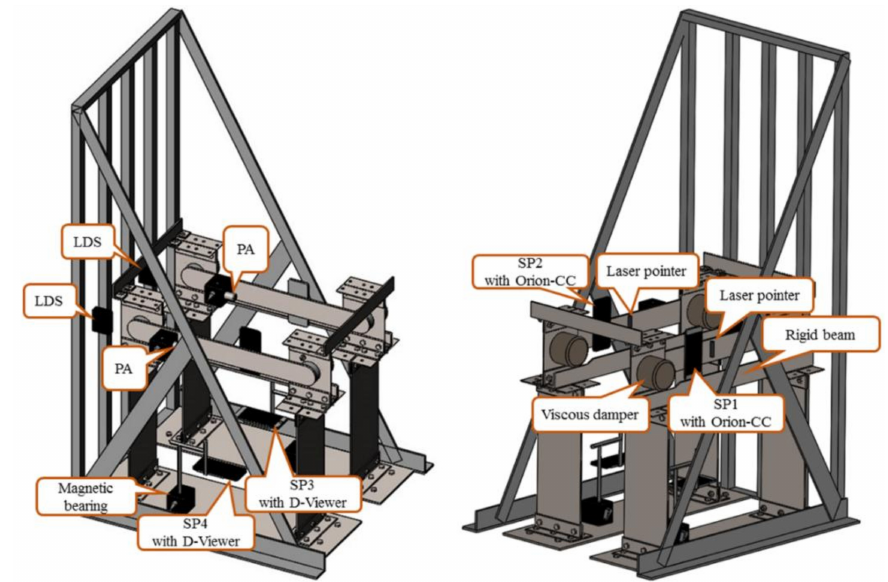
Figure 2. The various sensors instrumented in different locations in the steel frame testbed are